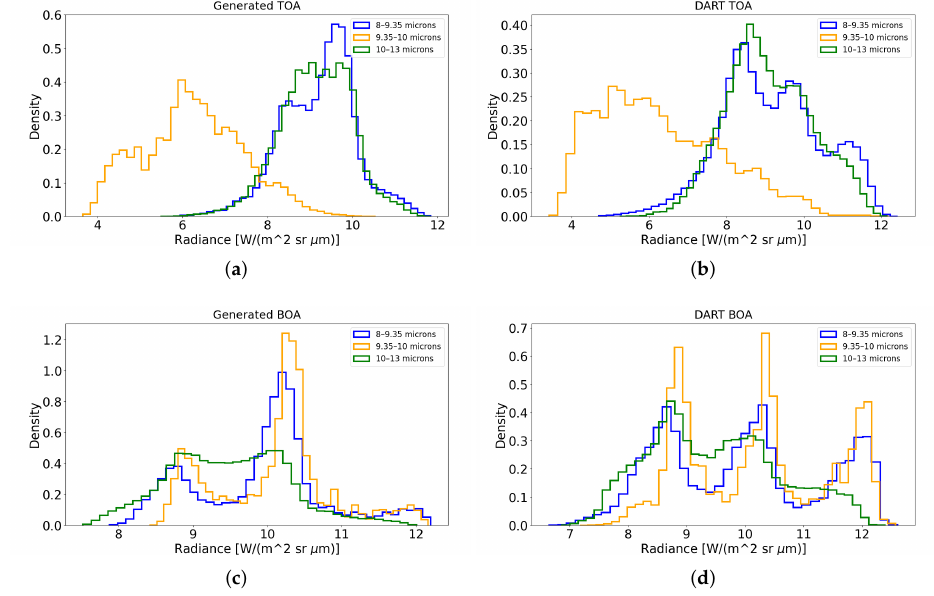
Figure 4. ( a ) Generated TOA radiance distribution. ( b ) DART TOA radiance distribution. ( c ) Gener- ated BOA radiance distribution. ( d ) DART BOA radiance distribution. Table 2. TOA and BOA mean values for the considered spectral regions. The mean and standard deviations values are reported both for the DART and GANDART datasets. The DART dataset is composed of 32,541 spectra, while GANDART of 1024. Spectral Region